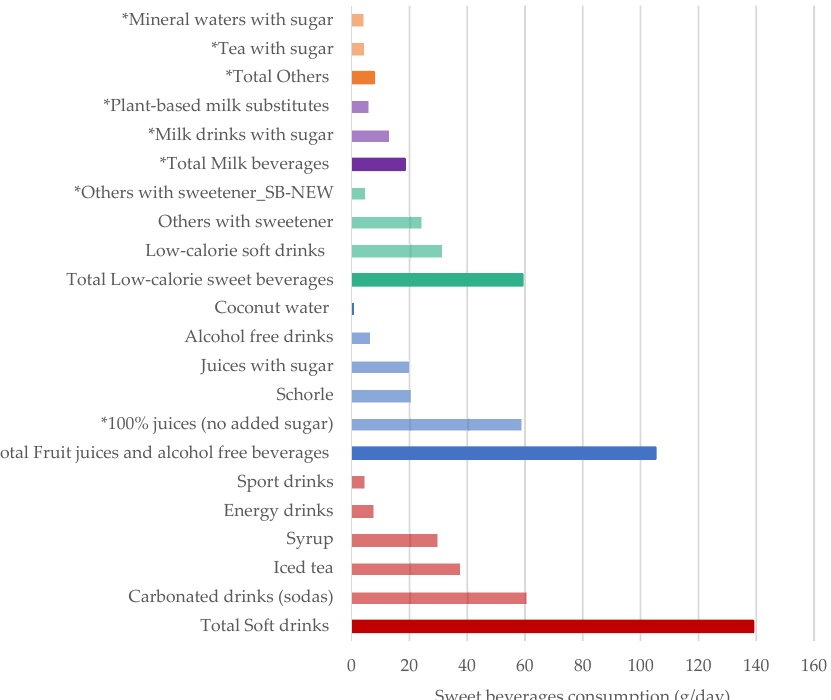
Figure 1. Weighted average consumption of sweet beverages (g / day) based on SB–NEW by sweet beverage category. All results were weighted for sex, age, marital status, major area of Switzerland, nationality, household size, season, and weekday. * Identifies all beverages excluded from the SB–CUR definition such as 100% juices (no added sugar), all milk beverages and all other beverages with added sugar or sweetener. The beverages are listed in ascending order, according to average intake (g / day).